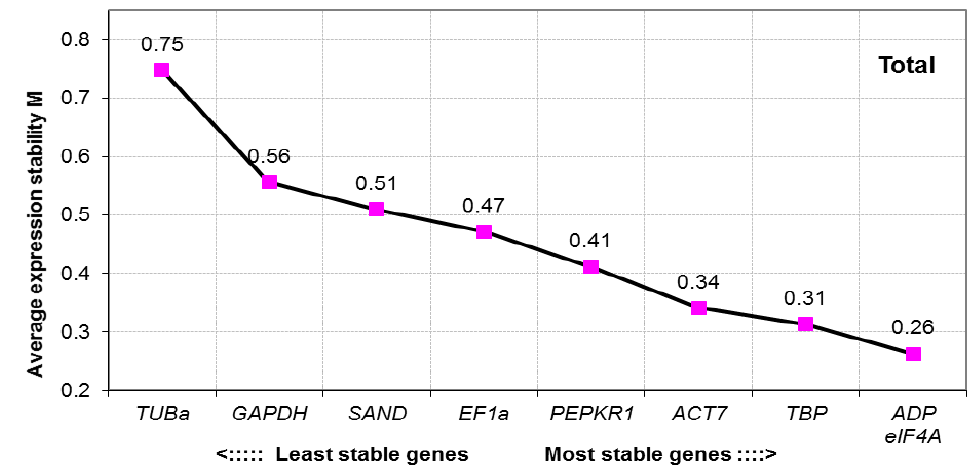
Figure 3. Average expression stability M of all remaining control genes after stepwise exclusion of the least stable reference genes according to the geNorm algorithm. The lower the M value the more stable is the gene’s expression in tested samples. Analysis was performed separately for ( a ) NaCl treated samples (NaCl), ( b ) PEG treated samples (PEG) and ( c ) all samples combined together (Total).